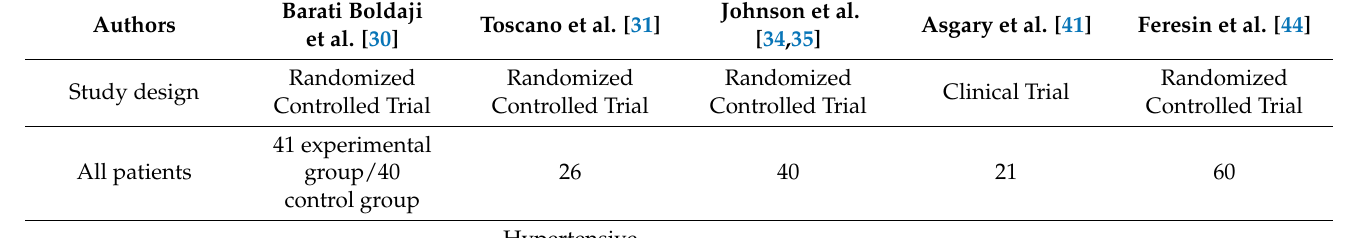
Table 4. Effects of specific nutrients on oxidative stress and